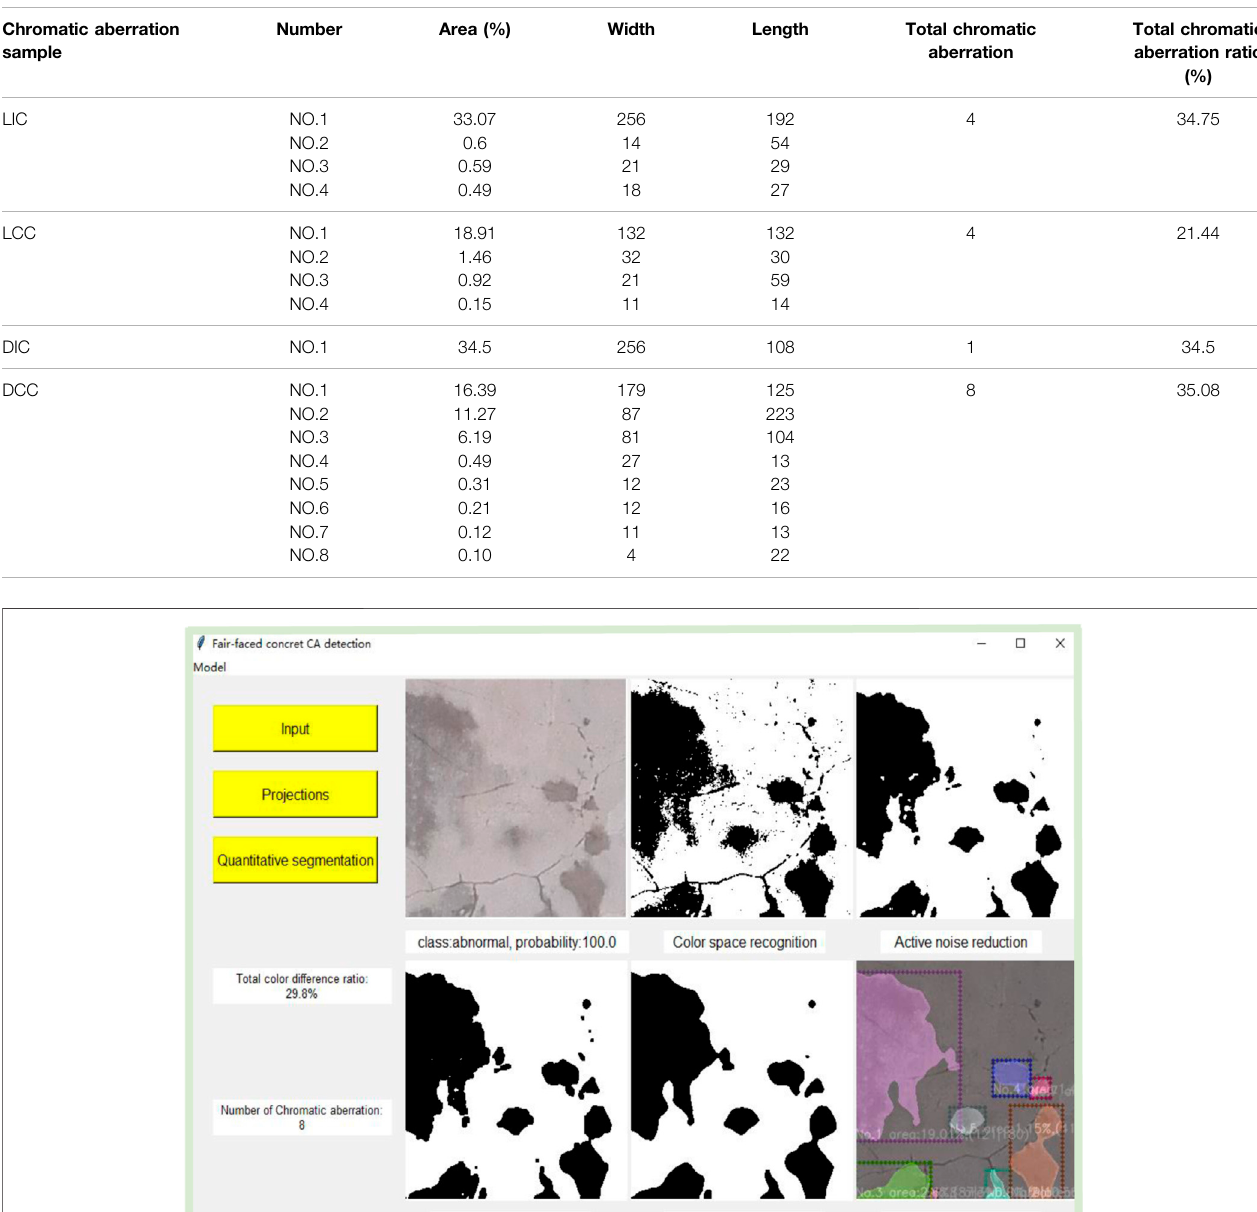
TABLE 4 | FFC chromatic aberration data of different defect categories.